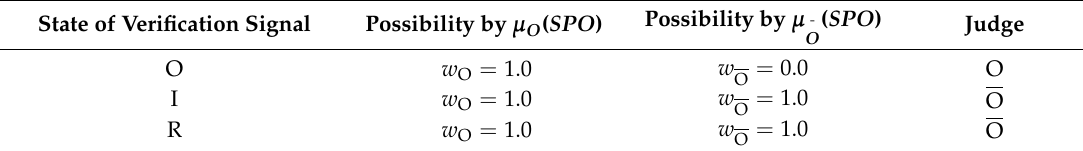
Table 8. Diagnosis results based on the Rule 1 of fuzzy inference